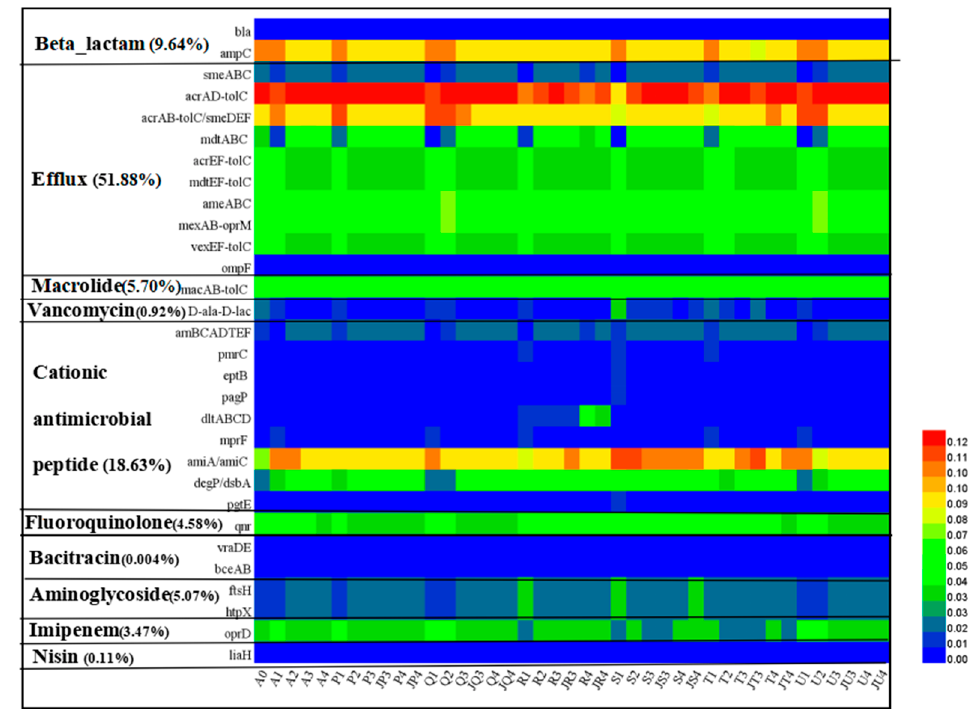
Figure 11. Heatmap analysis of antibiotic resistance genes (ARGs) in all the samples. Percentages in parentheses represent the distributions of antibiotics to which these ARGs confer resistance.